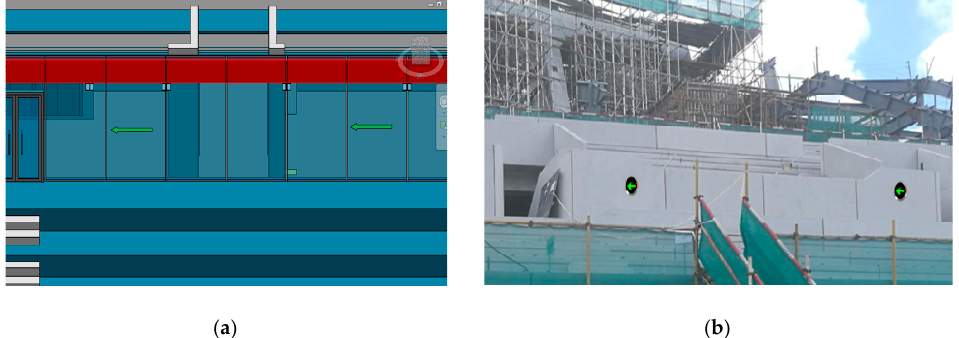
Figure 9. Path planning of material allocation. ( a ) Path simulation in virtual model; ( b ) Material allocation on